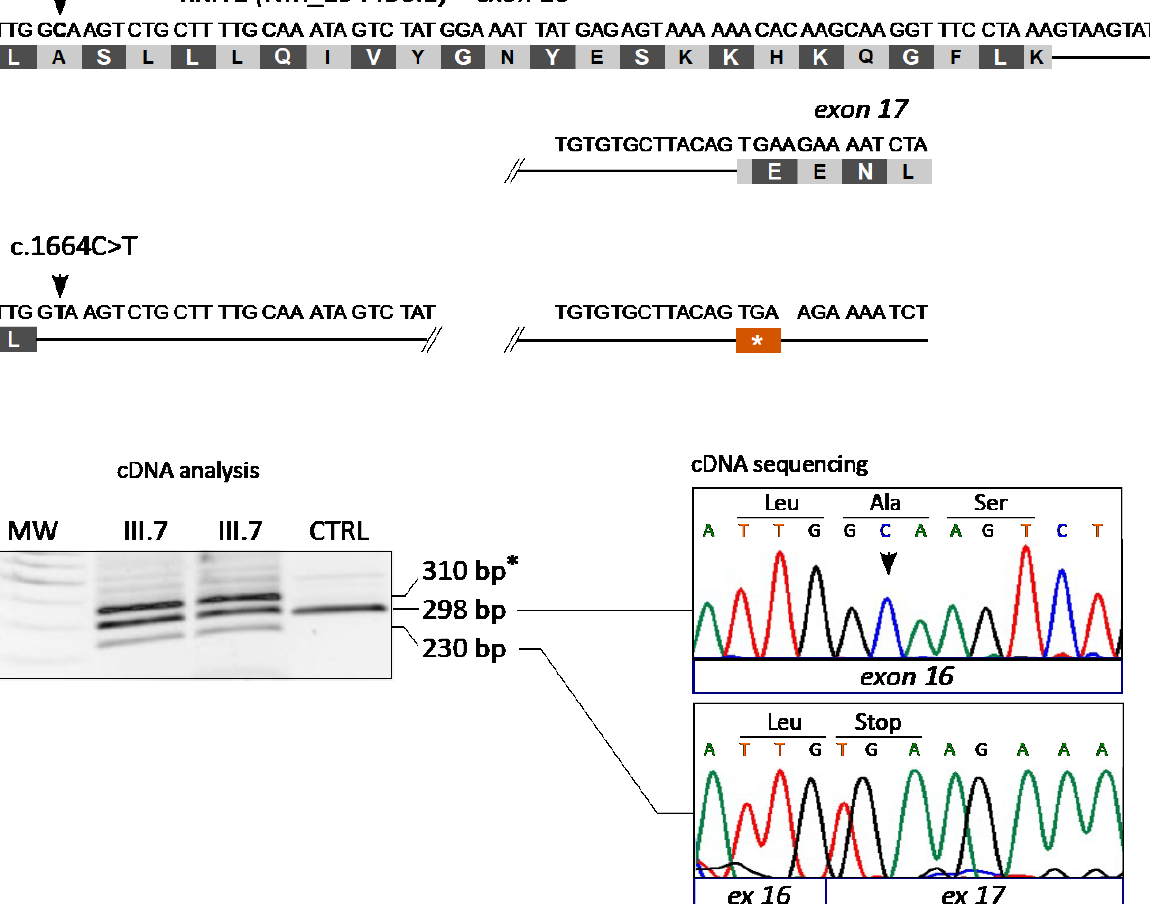
Figure 3. Molecular analysis of the KRIT1 c.1664C>T variant. ( A , B ) Schematic representation of the KRIT1 exons 16–17 region in wild-type ( A ) and c.1664C>T mutated ( B ) transcripts. ( C ) Molecular analysis of the KRIT1 c.1664C>T change at the mRNA level. Total RNA isolated from peripheral blood samples of two affected members of family 12 (III.7 and II.1) and a control was reverse transcribed into cDNA and analyzed by PCR amplification with a pair of forward and reverse primers localized in exons 15 and 17 of KRIT1 , respectively, followed by agarose gel electrophoresis (left panel) and Sanger sequencing (right panel) of purified PCR products. The resulting sequencing electropherograms (right panel) showed that the 298 bp and 230 bp bands corresponded, respectively, to the wild-type KRIT1 transcript and to an anomalous splicing product devoid of the last 68 nucleotides of exon 16, which leads to the formation of a premature stop codon due to an in-frame TGA sequence in the three first nucleotides of exon 17. Asterisk (*) indicates a likely heteroduplex band. To address this hypothesis, we isolated RNA samples from the white blood cells of two affected members of family 12 (III.7 and II.1) and a control (CTRL) and performed